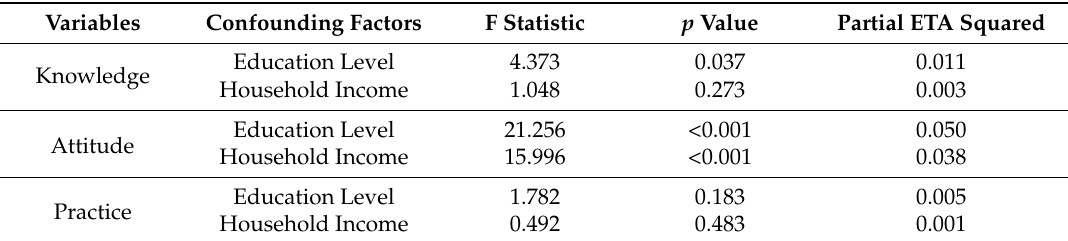
Table 6. The Effect of Confounding Factors on Knowledge, Attitude, and Practice marks between Hotspot and Non-hotspot